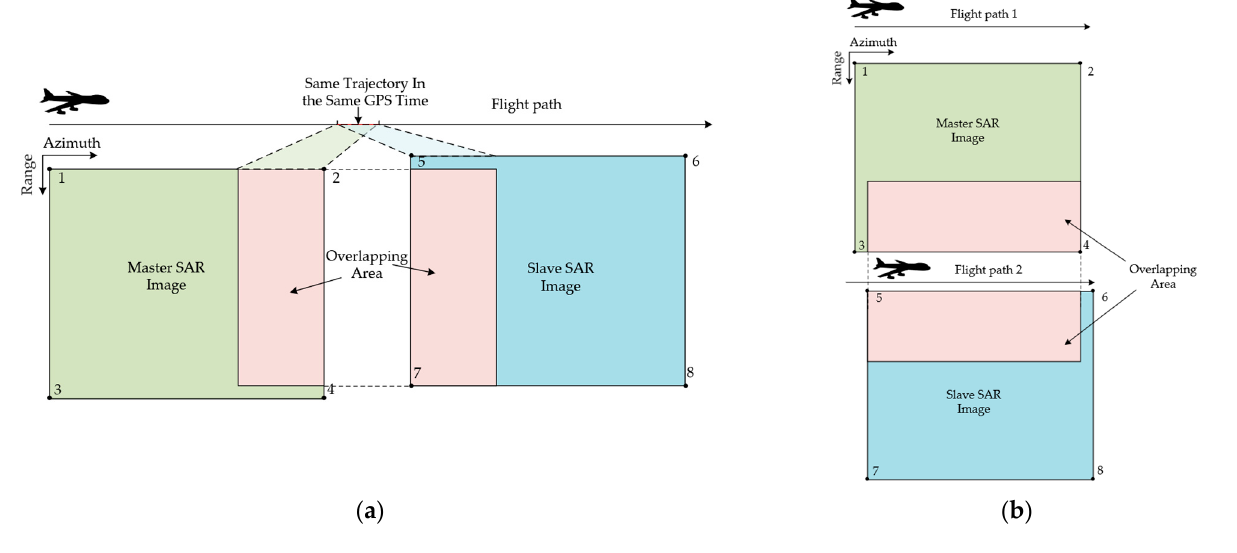
Figure 3. Calculation of overlapping area, where ( a ) is the same-strip case and ( b ) is the different- strip case.